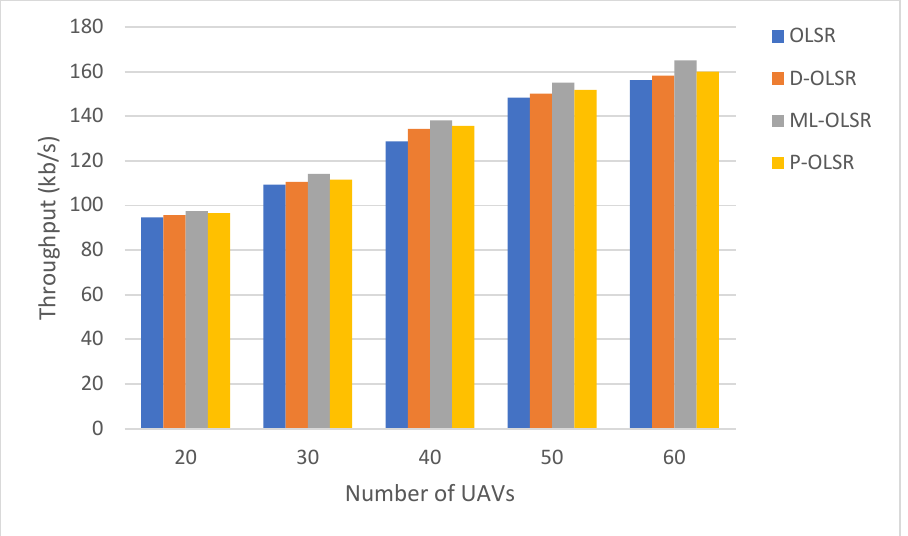
Figure 13. Throughput vs. number of UAVs